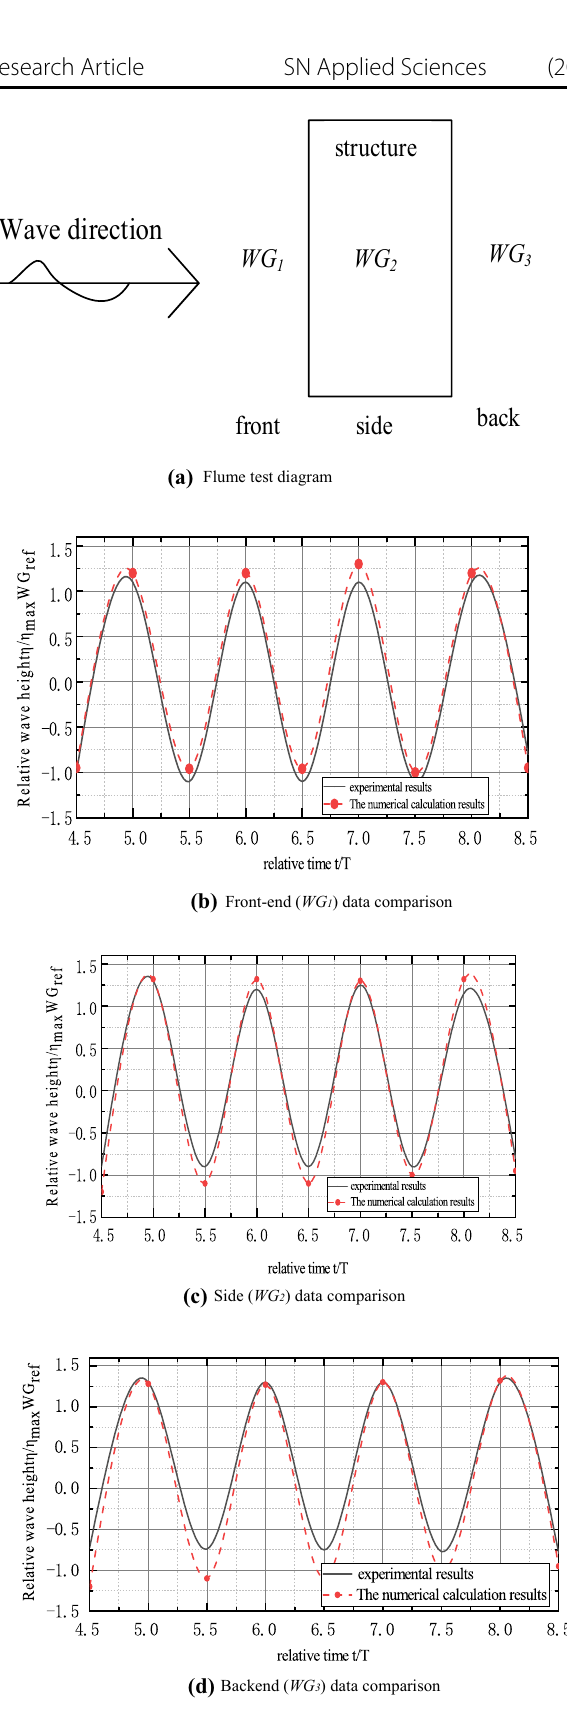
Fig. 3 Comparison of relative wave elevation time-history